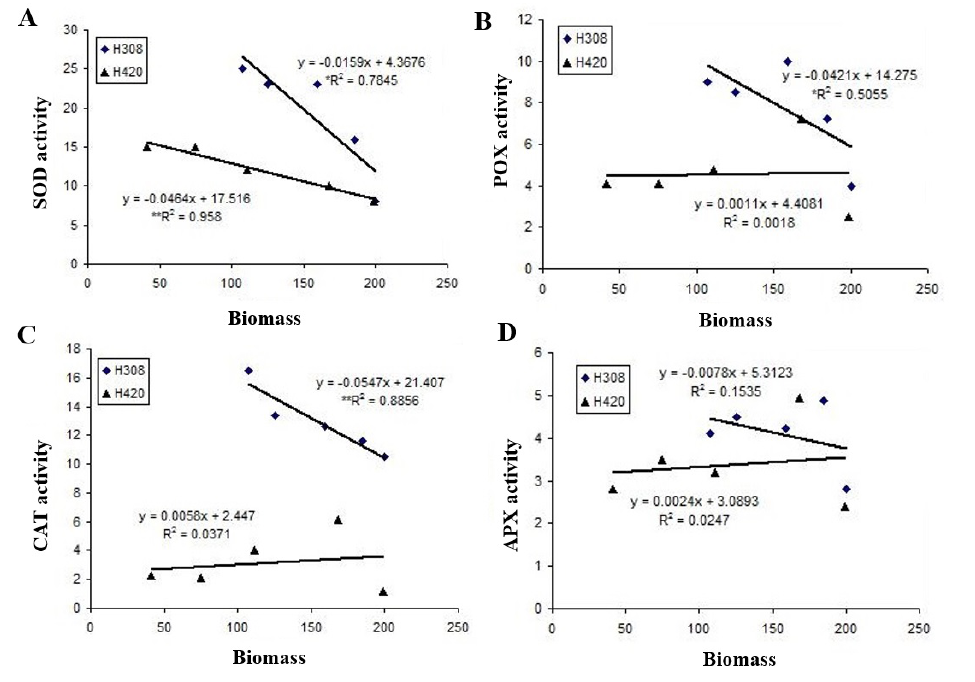
Fig. 8. The correlations between biomass and free radical scavenger enzymes activity in two canola genotypes (H308, H420). ** , * mean significant at P<0.01 and P<0.05,